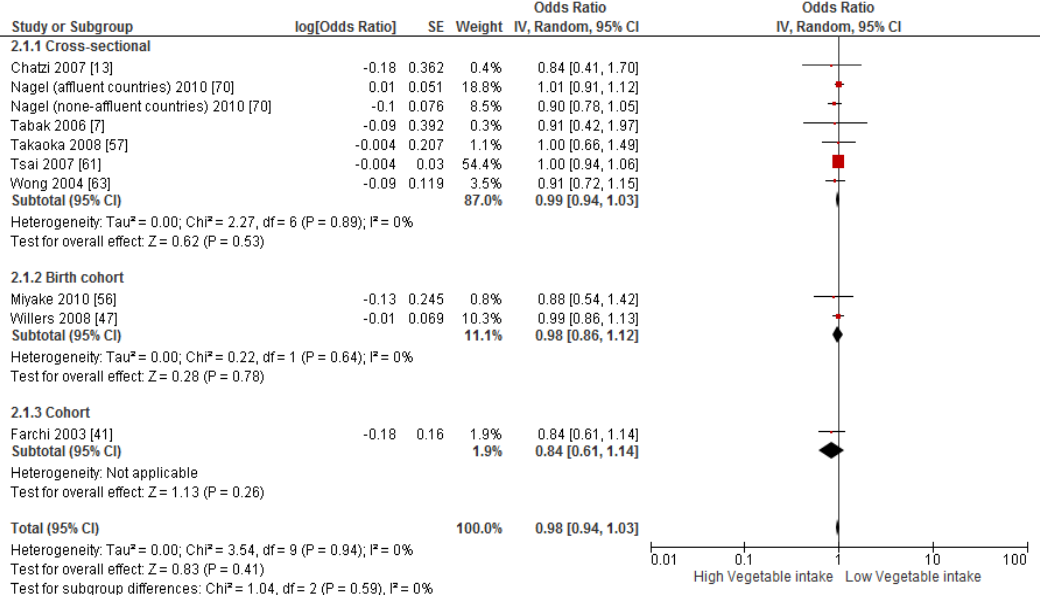
Figure 8. Meta ‐ analysis of the association between vegetable intake and risk of prevalent wheeze. Figure 8. Meta-analysis of the association between vegetable intake and risk of prevalent